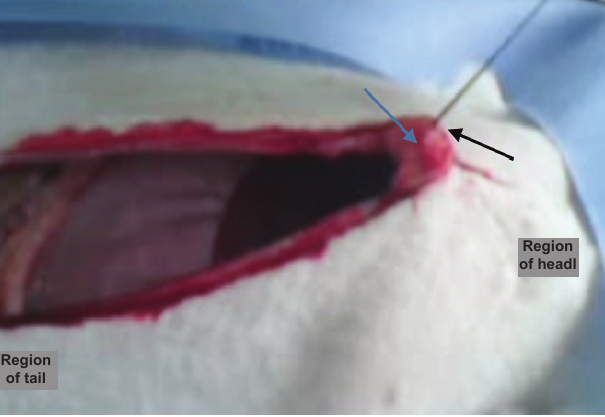
FIGURE 3 - Photograph demonstrating the fixation of the xiphoid process in the thorax wall. Black arrow identifies the point that the cotton thread penetrates the xiphoid process and the blue arrow identifies the xiphoid